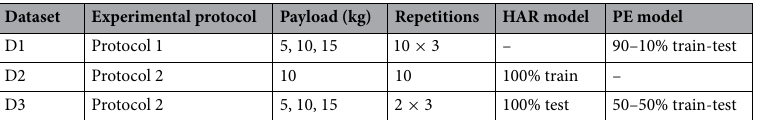
Table 1. Datasets used for model training and testing obtained combining data acquired with the experimental protocols designed for this study.